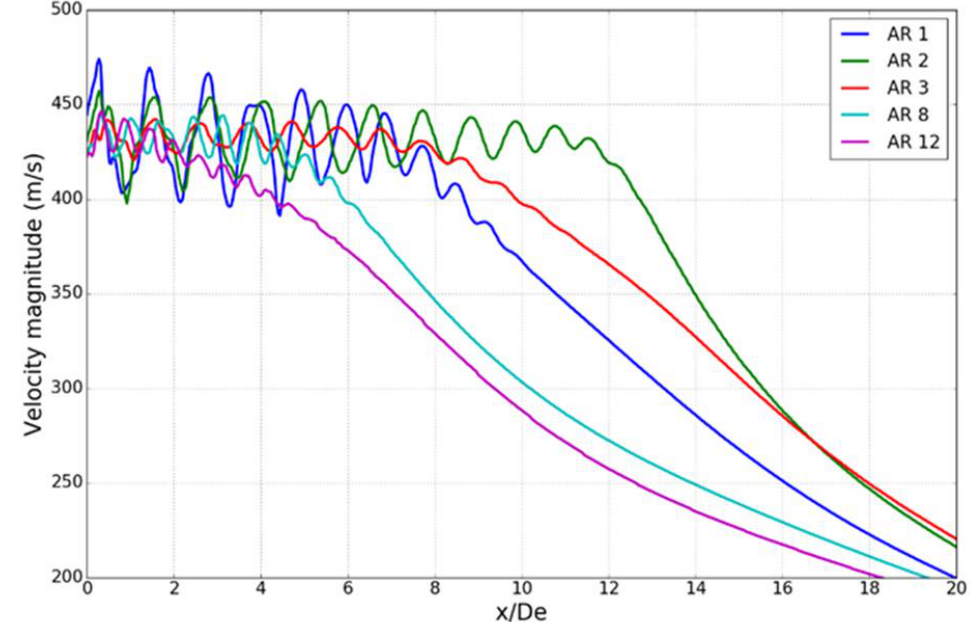
Figure 7. Jet centerline velocity downstream the nozzle exit. Figure 7 . Jet centerline velocity downstream the nozzle exit.